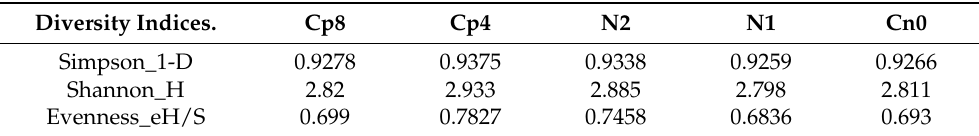
Figure 3. Relative abundance of archaeal community at genus level present in the maize rhizosphere soil under fertilized and unfertilized treatments. Cp8 (8 tons/ha compost), Cp4 (4 tons/ha compost manure), N2 (120 kg/ha NPK), N1 (60 kg/ha NPK), and Cn0 (control). Table 2. Diversity indices of the phosphorus cycling genes within the rhizosphere of maize plants under